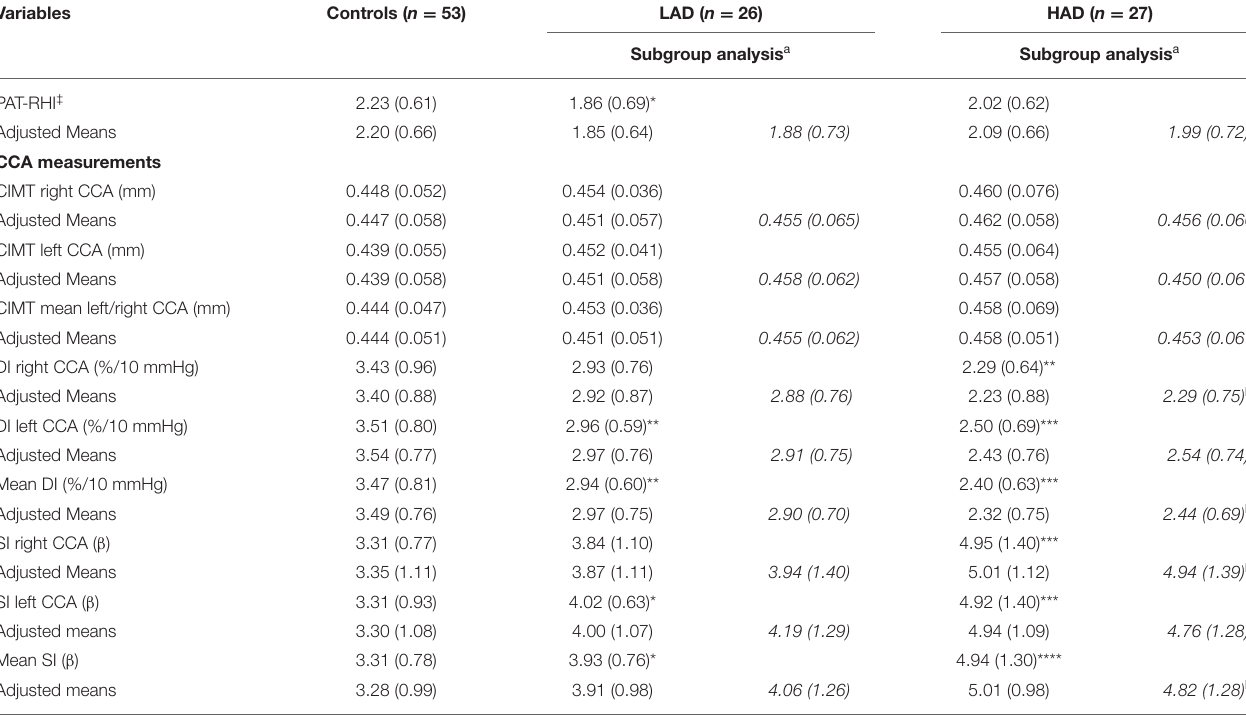
TABLE 3 | Vascular outcomes in controls and childhood cancer survivors with low (LAD) or high (HAD) cumulative dose of anthracyclines. Variables